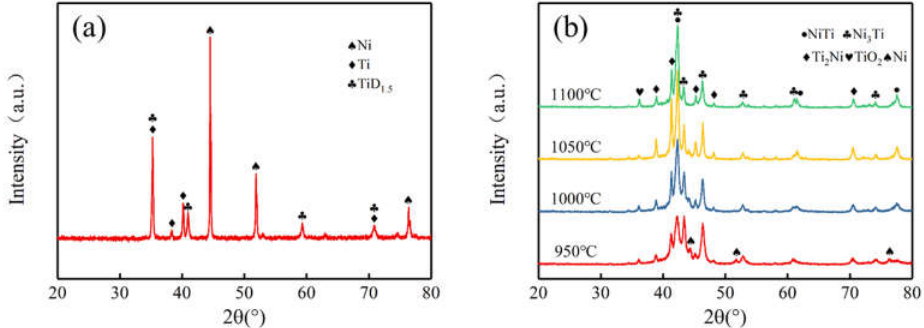
Figure 5. XRD patterns: ( a ) Ni-Ti blended powders; ( b ) porous NiTi